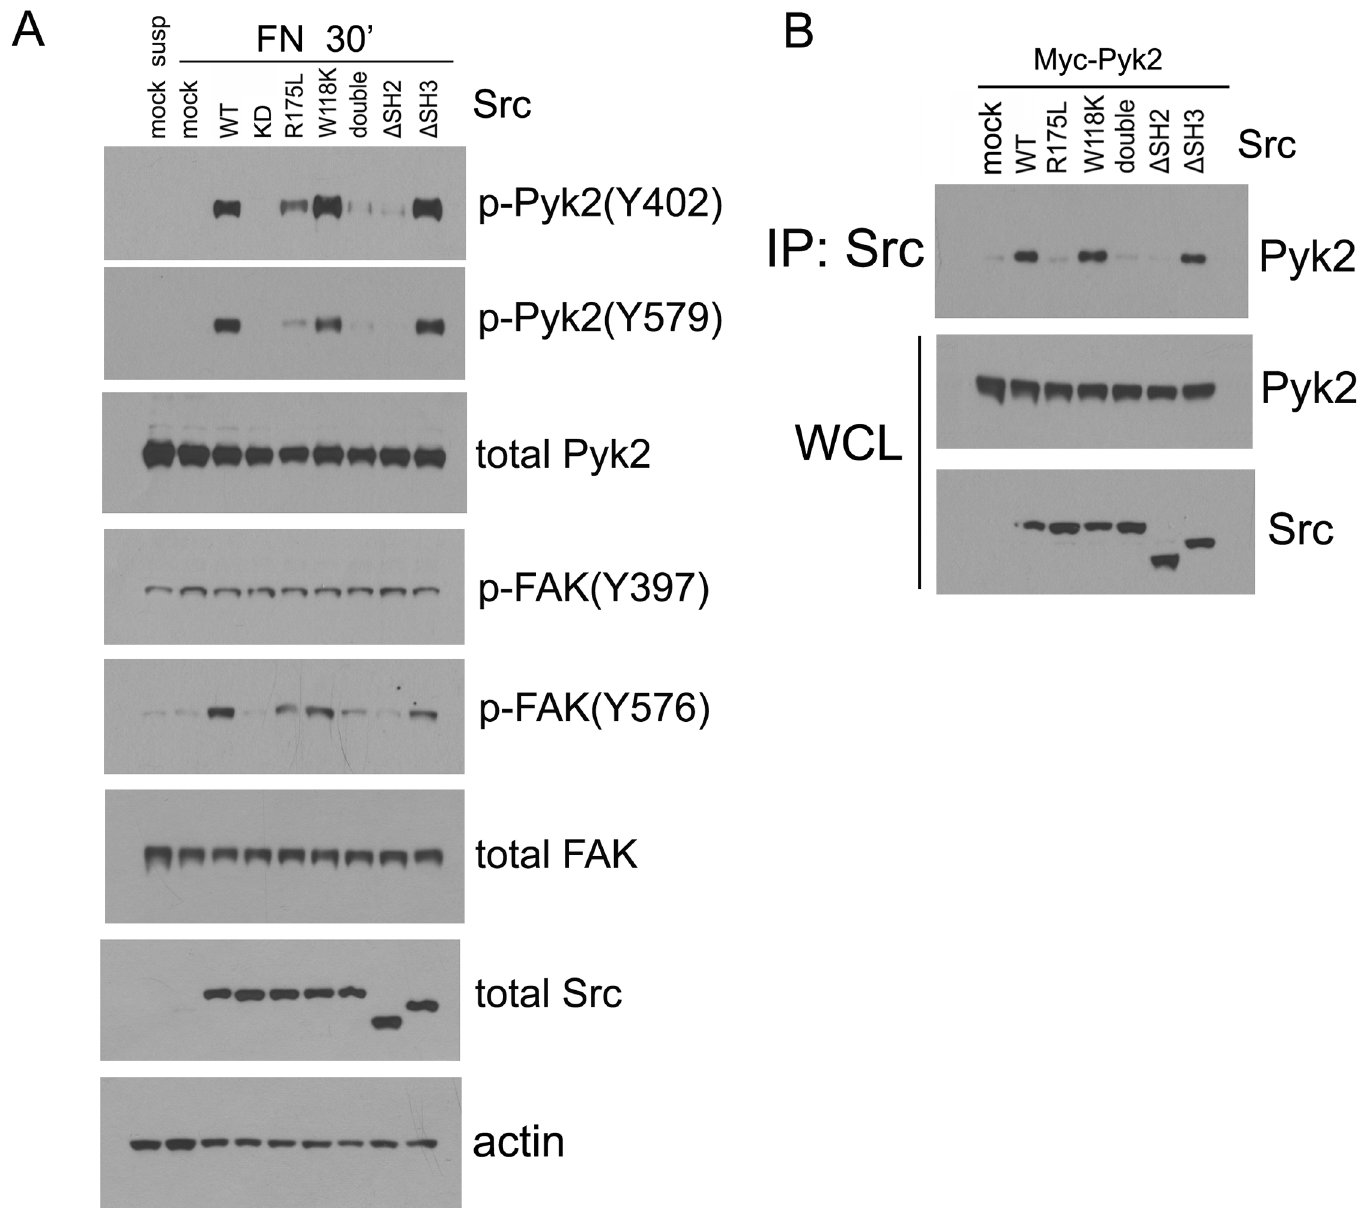
Fig 2. Analysis of proteins domains of Src involved in Pyk2 phosphorylation. A, SYF cells transiently transfected with Src-WT or the various Src mutant constructs were serum-starved, detached and kept in suspension in DMEM containing 0.5% BSA for 1 hr. Cells were then seeded on fibronectin-coated dishes, and allowed to attach for 30 min. Phosphorylation of Pyk2 and FAK was examined by immunoblot. B, Co-IP of Src and Pyk2. SYF cells were transiently transfected with Myc-Pyk2 along with Src-WT or Src mutant constructs, the expressed Src was immunoprecipitated and the associated Pyk2 was examined by